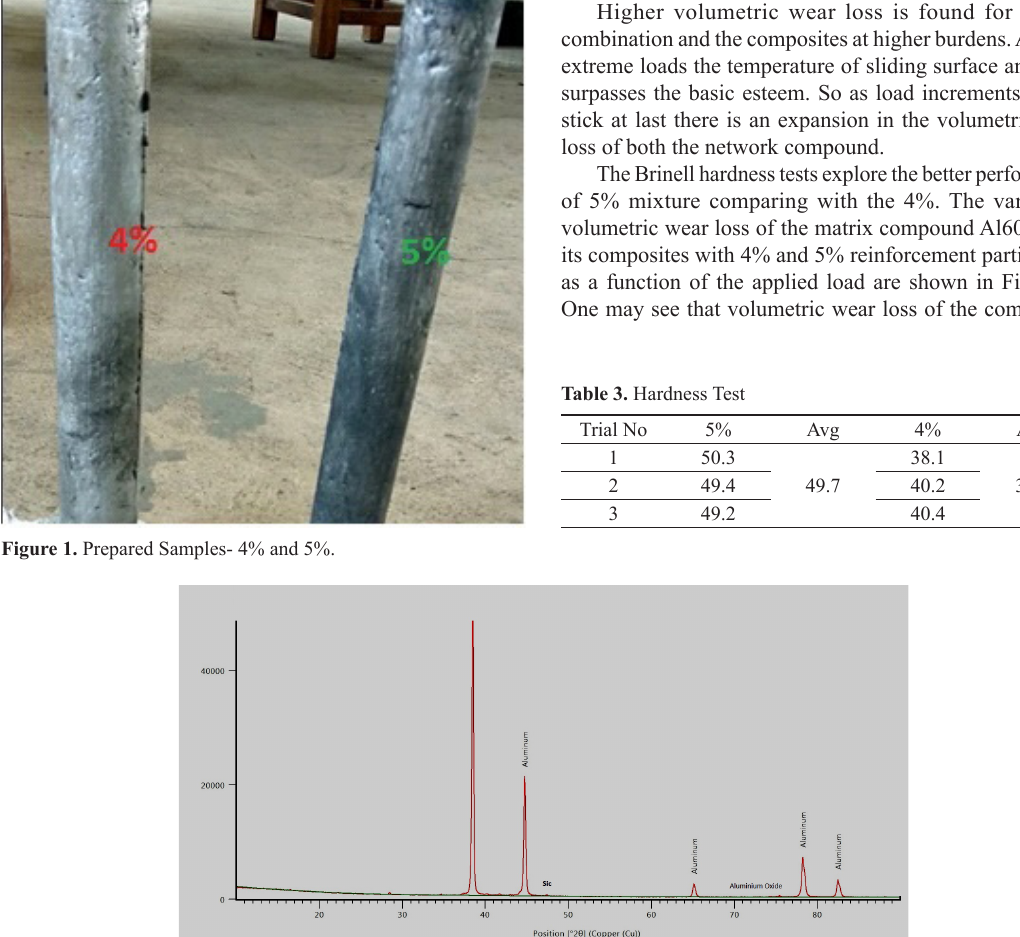
Figure 2. X-Ray Diffraction Analysis Pattern of 4% of Reinforcement. (SiC, graphite, B4C,